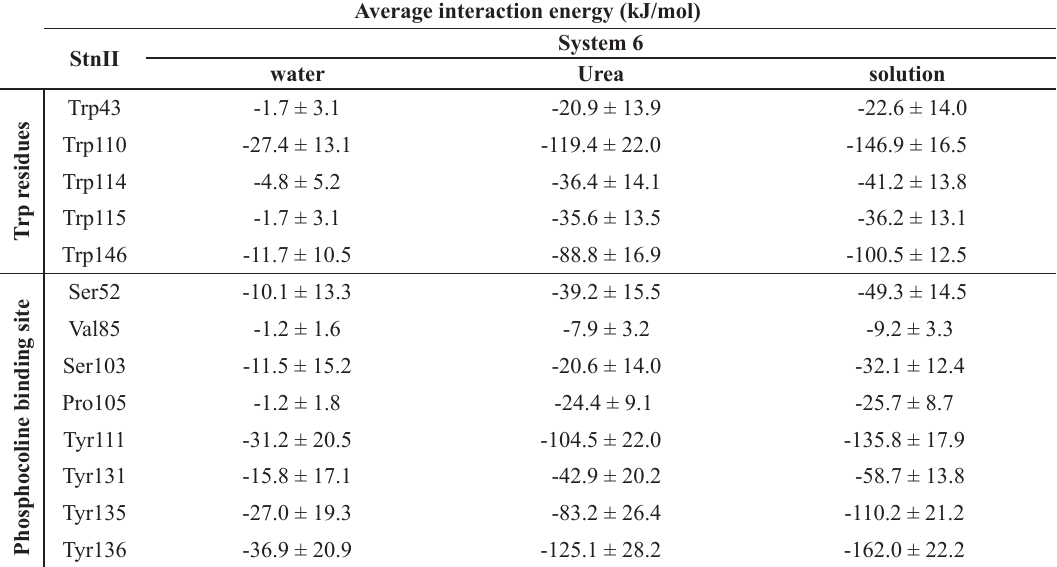
Interaction energy analysis between Trp and phosphocoline binding site residues of StnII and solution molecules present in a 10.0 M urea solution.